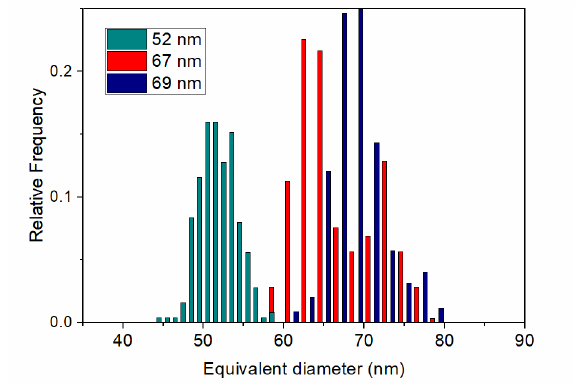
Figure S1. Size-distribution of the as-synthesized UCNPs from three different batches used in this study. The average sizes of the specific batch were 52 ± 2 nm, 67 ± 5 nm and 69 ± 3